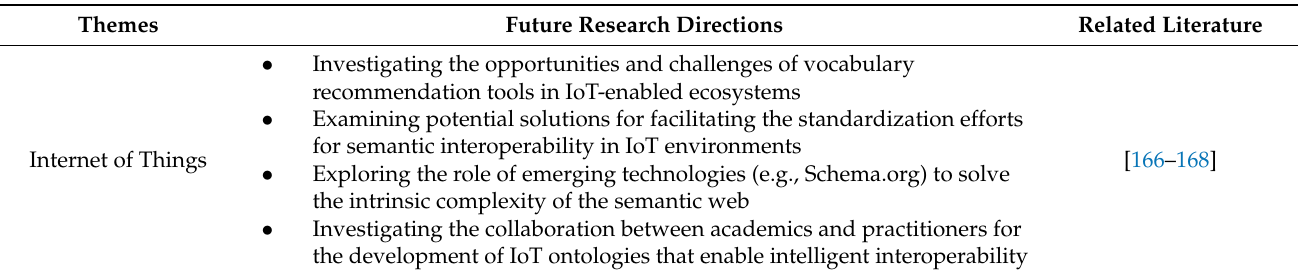
Table 11. Agenda for future research based on co-citation